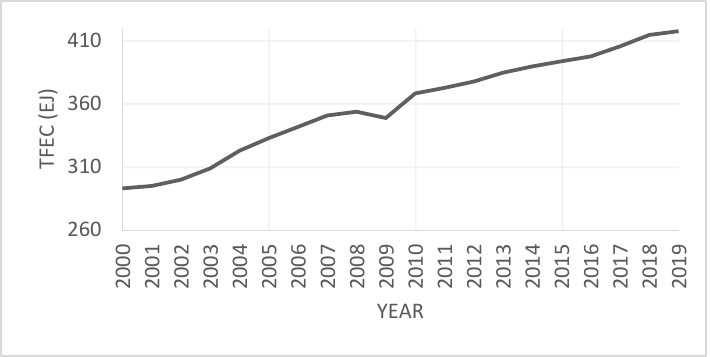
Figure 1. Global total final energy consumption (TFEC), 2000–2019. Data source: IEA [18].